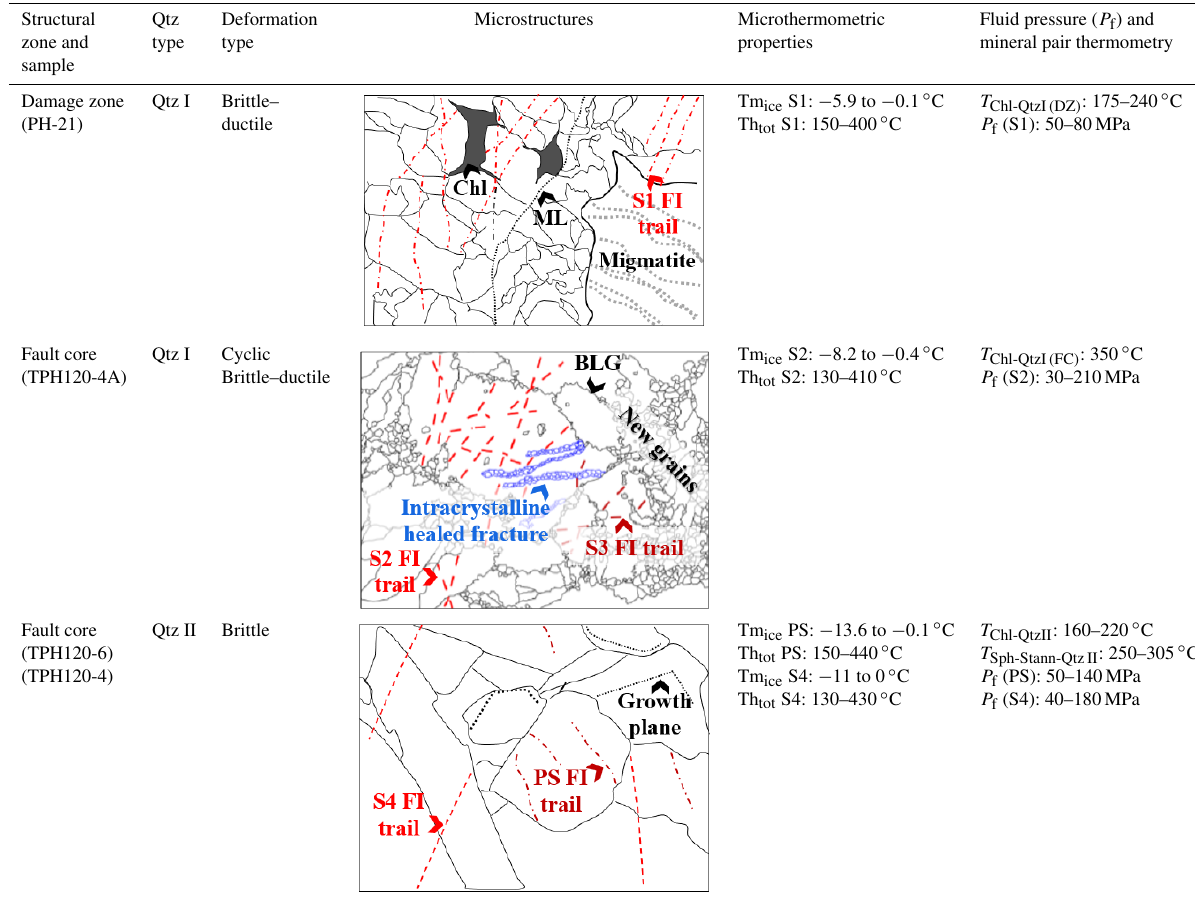
Table 1. Schematic summary of main microstructures, fluid properties, and P – T deformation conditions in the quartz veins of the BFZ300